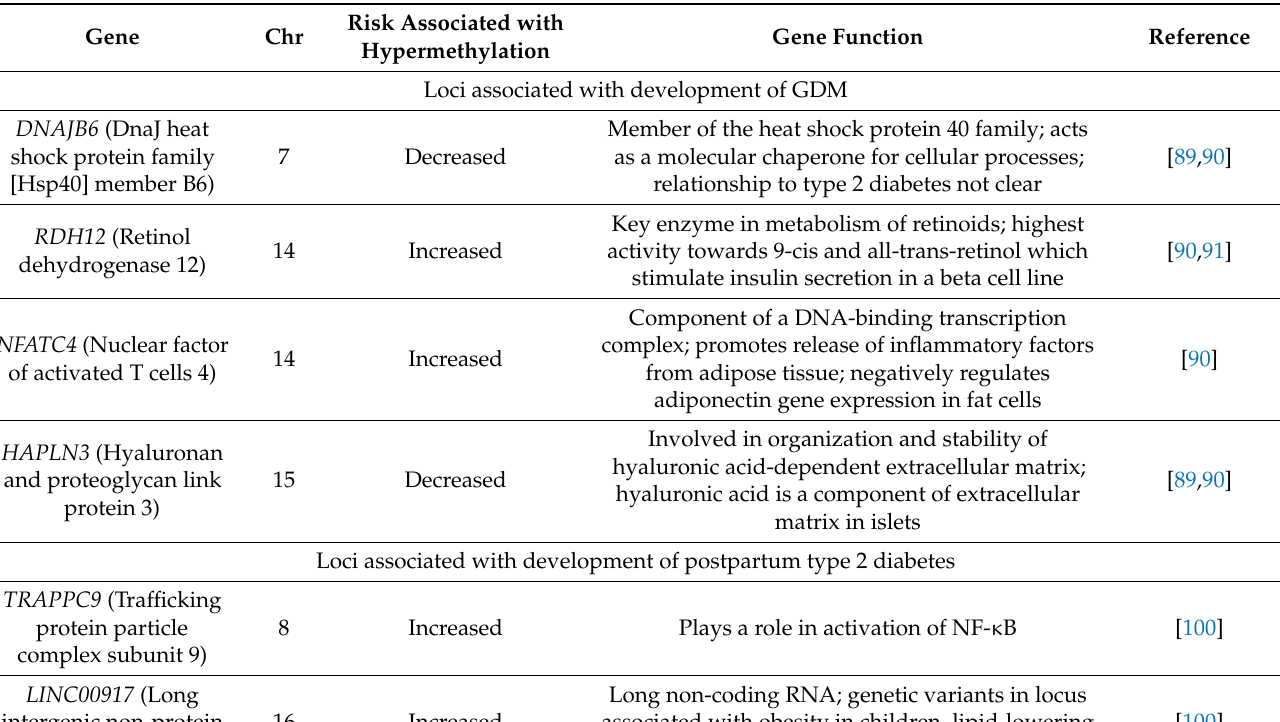
Table 2. Genetic loci with replicated changes in methylation associated with development of GDM or postpartum type 2